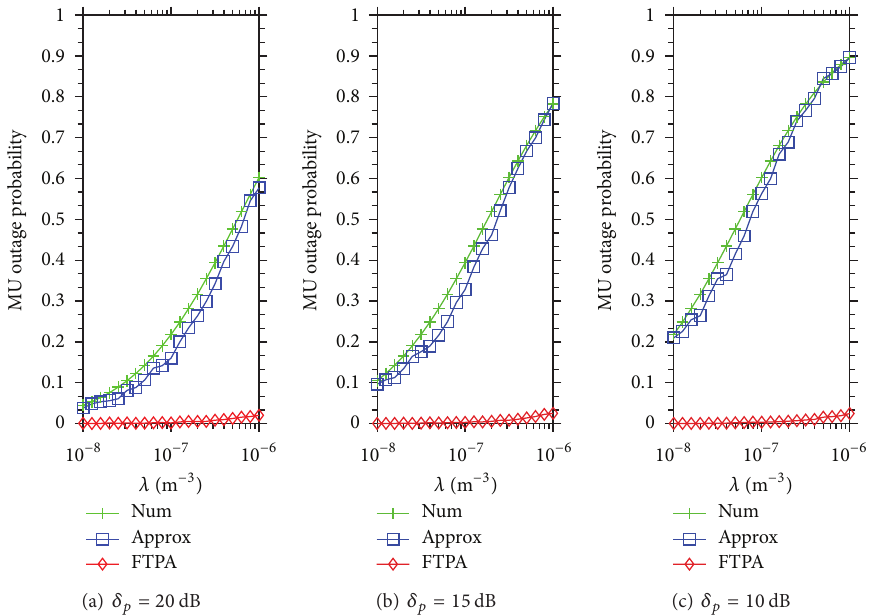
Figure 3: MU outage probability caused by Approx and FTPA versus the density of FBSs development when the QoS type of each MU is CBR video ( 𝜓 3 𝑚 = 9.32